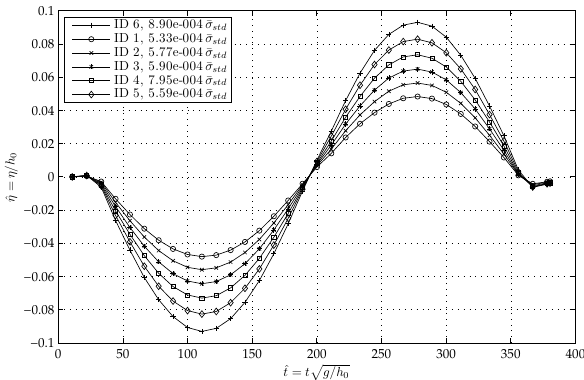
Fig. 3. Averaged non-dimensional surface elevation history for the six utilized waves, the markers denote the different waves heights, ¯ σ std is the averaged standard deviation calculated from the entire number of experiments in each